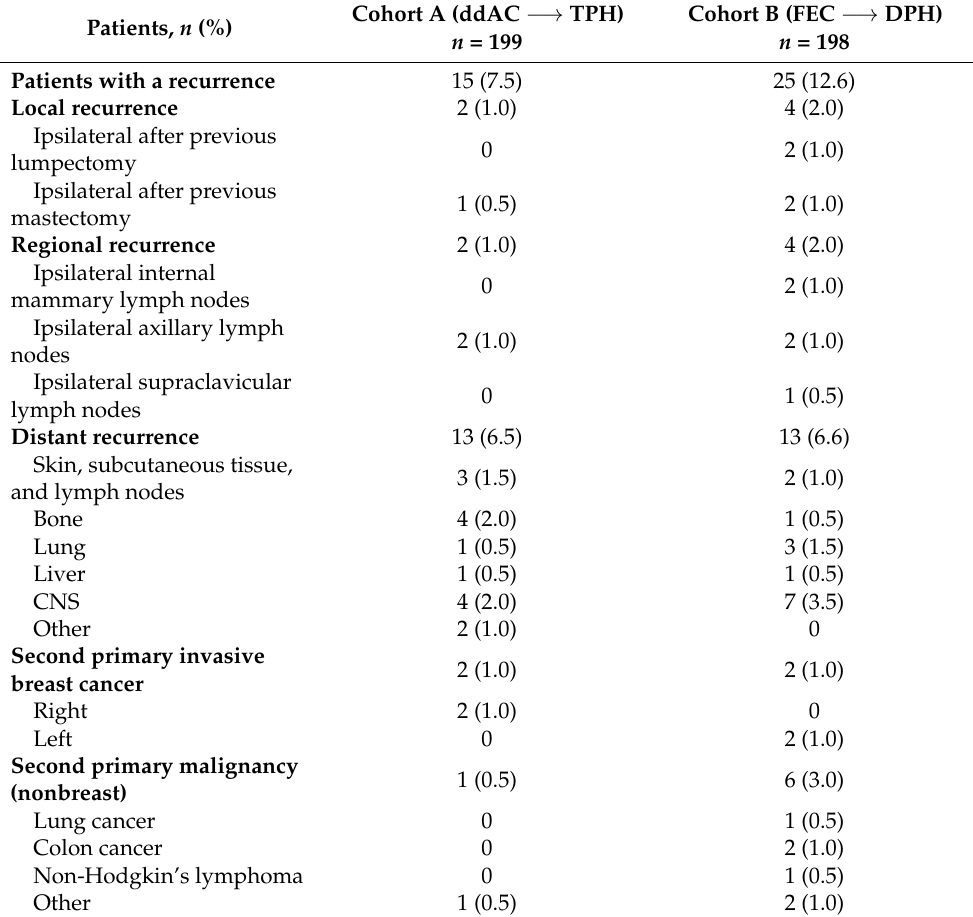
Table 4. Summary of site of first